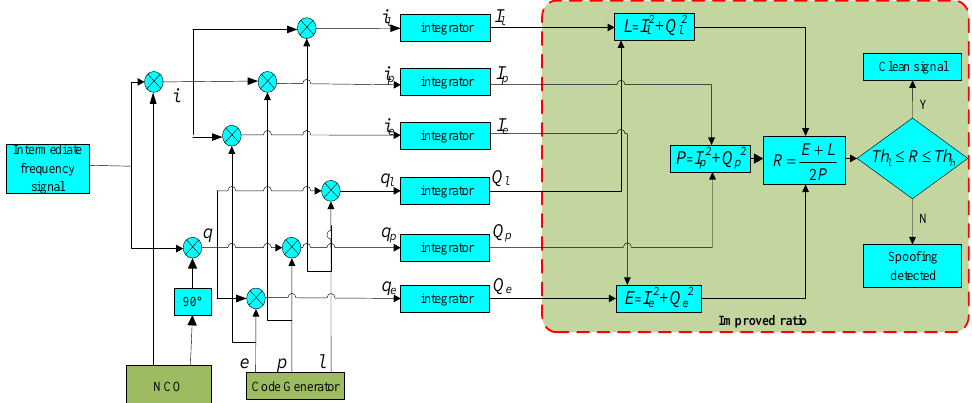
Figure 4. Detection model with Improved Ratio.